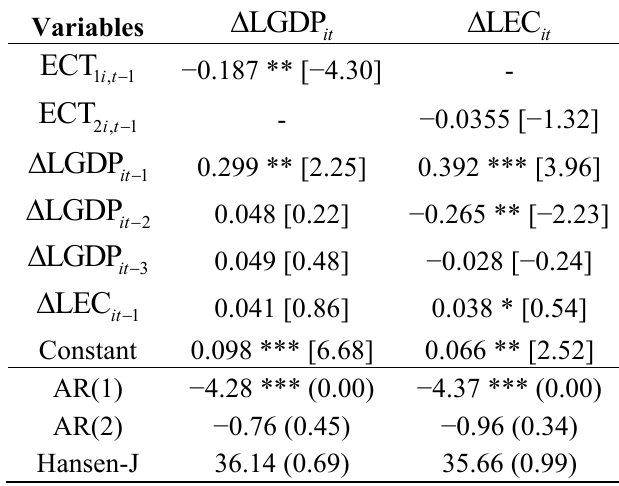
Table 6. System generalized method of moments (SYS-GMM)